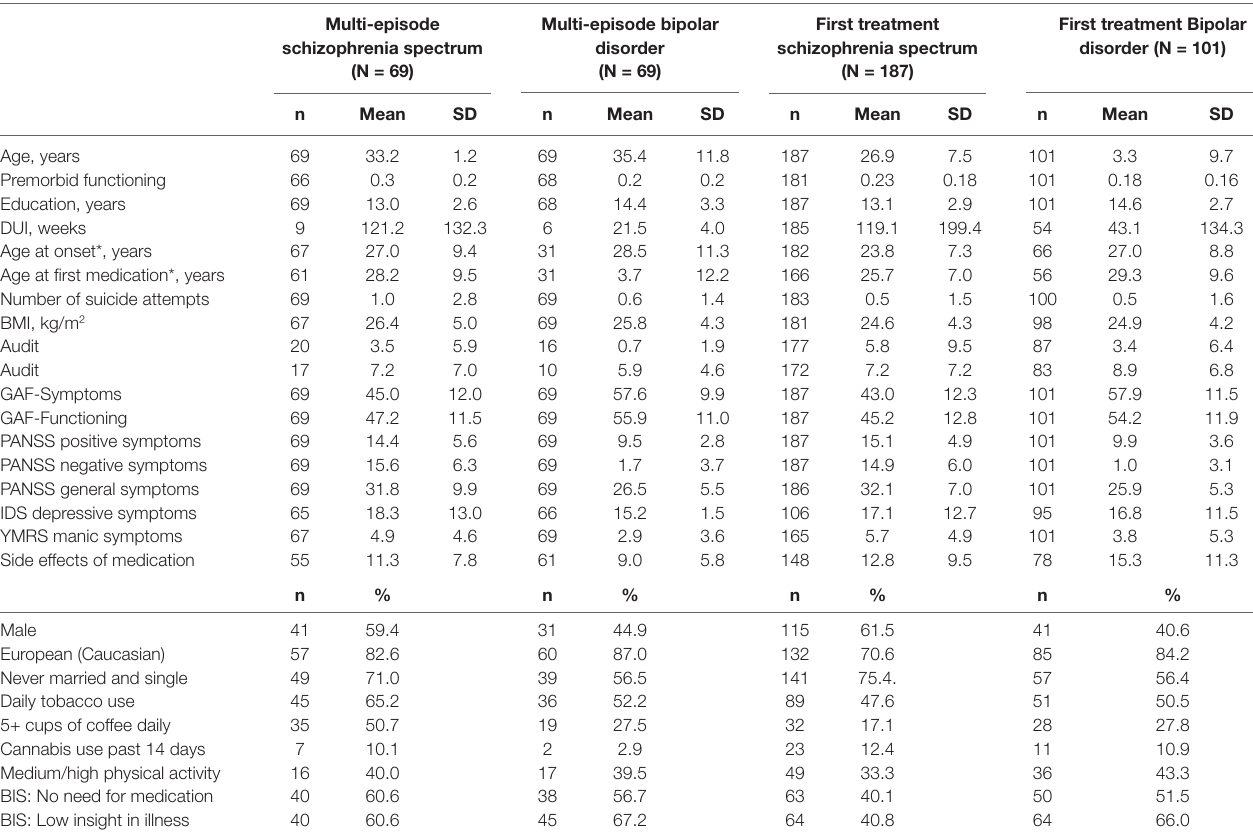
TABLE 2 | Demographic and clinical characteristics of groups at first